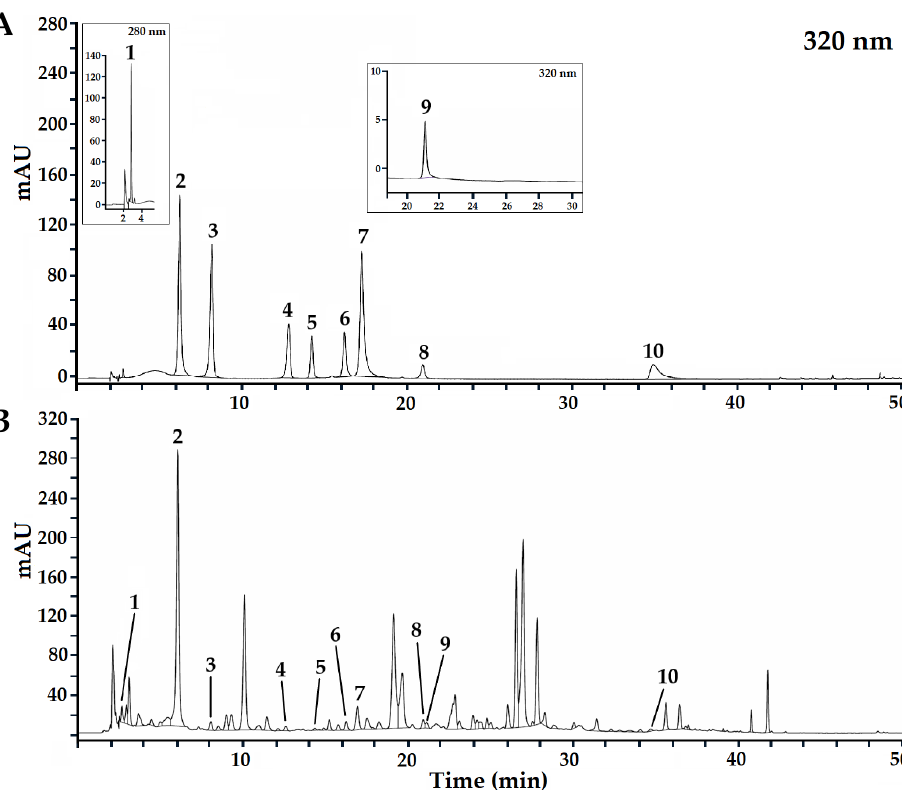
Figure 1. Chromatographic profile based on HPLC-DAD analysis of standard compounds identified ( A ) and methanolic extracts from A. petiolaris ( B ): (1) gallic acid, (2) chlorogenic acid, (3) caffeic acid, ( 4) ρ -coumaric acid, (5) robinin, (6) rutin, (7) luteolin-7-glucoside, (8) apigenin-7-glucoside, (9) rosmarinic acid and (10) kaempferol. Table 4. Significance of square means of analysis of variance regarding phenolic acids and flavo- noids evaluated in A. petiolaris by HPLC-DAD.